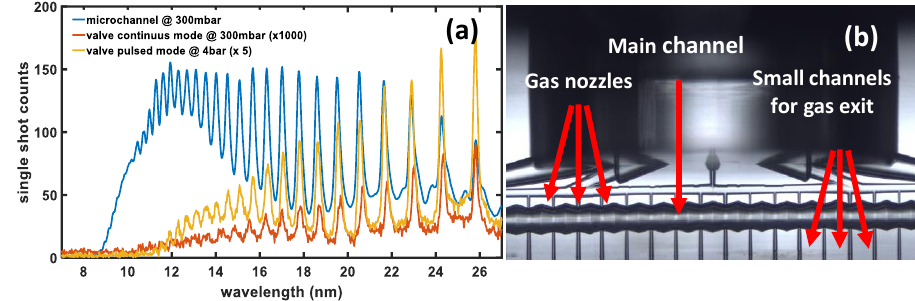
Figure 2 (a) Comparison between HHG spectra produced in helium inside the microchannel (blue), in a continuous gas jet (red) and in a pulsed gas jet (yellow). (b) QPM device. It is composed of a main channel with a periodic modulation of the diameter, multiple gas nozzles and small channels for gas